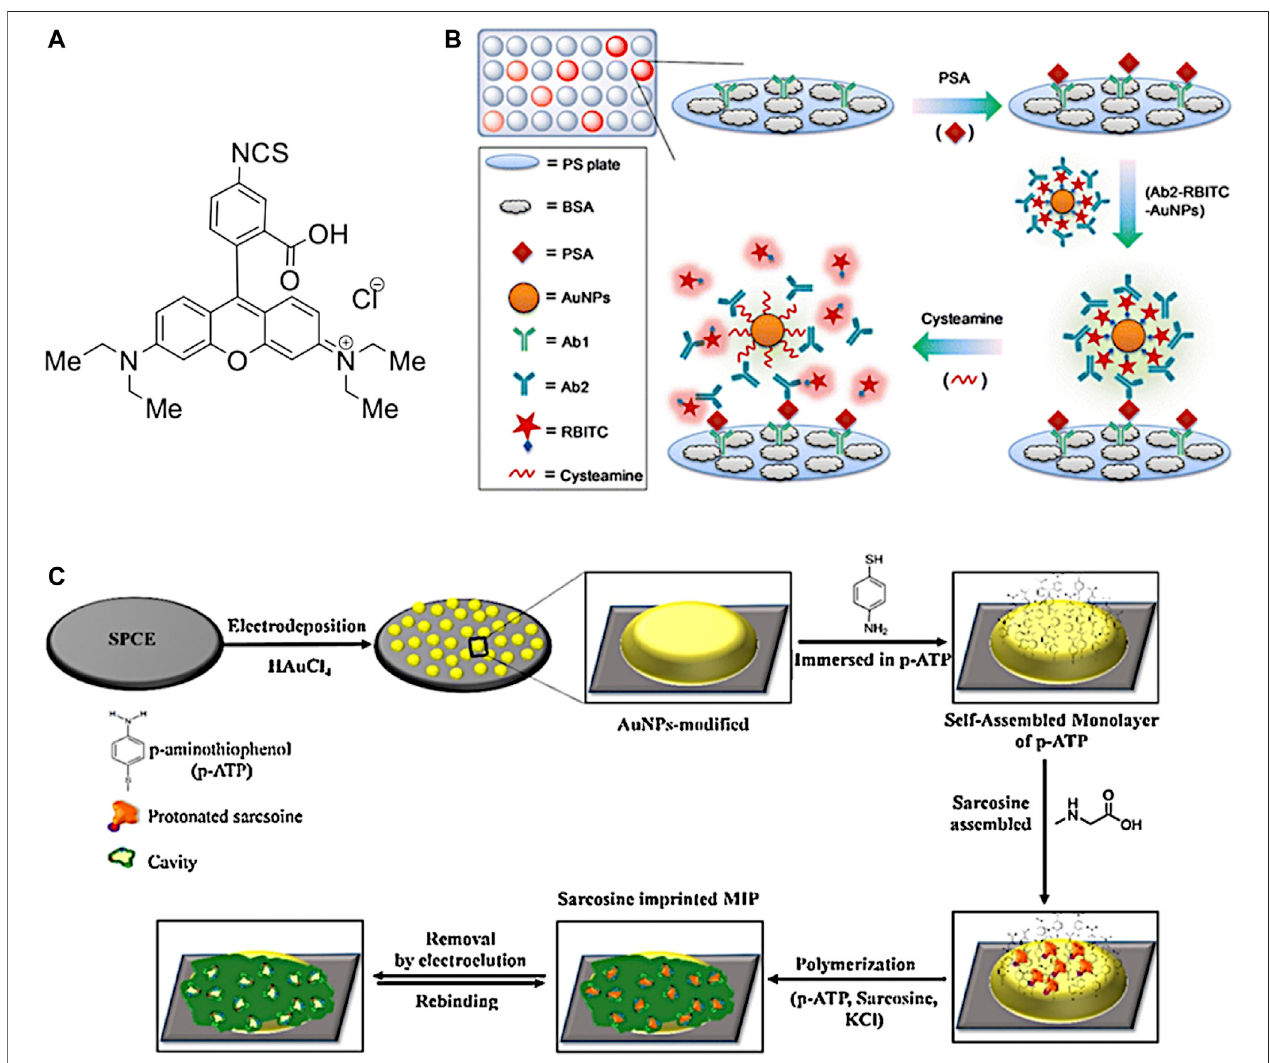
FIGURE 12 | (A) Example of a fl uorescent dye (denoted RBITC) used in the synthesis of the fl uorescence-activated probe Ab2-RBITC-AuNP, (B) procedure as demonstrated by D. Liu et al. for the synthesis of the AuNP activated probe for early PSA detection ( fi gure adapted from Ref (Liu et al., 2013)) (C) an overview of the procedure in described for the formation of MIP/AuNPs/SPCE ( fi gure adapted from (Nguy et al.,